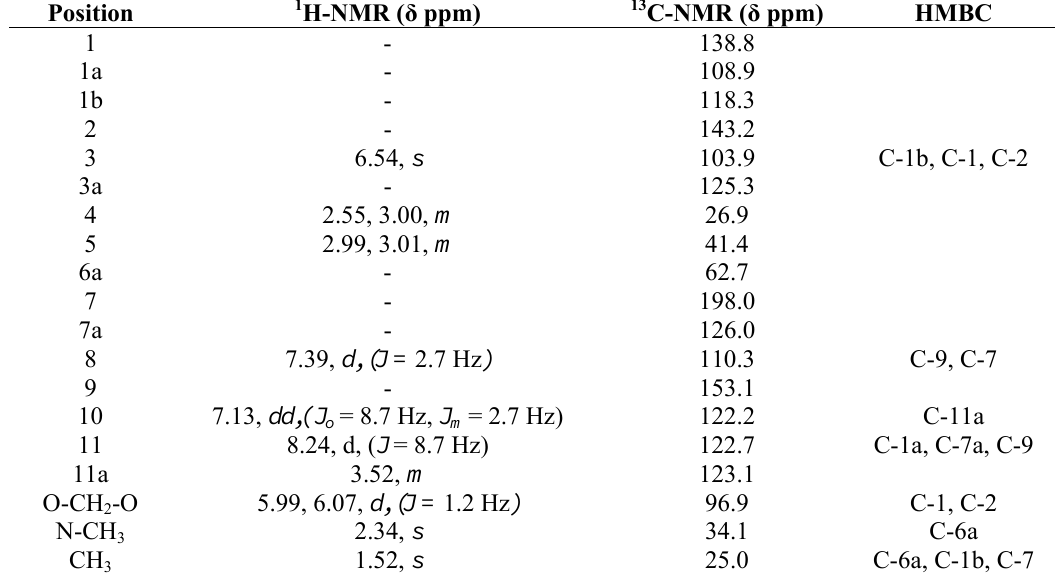
Table 1. 1 H-NMR (300 MHz) and 13 C-NMR (75 MHz) spectral data of compound 1 in CD OD ( δ in ppm, J in Hz 3